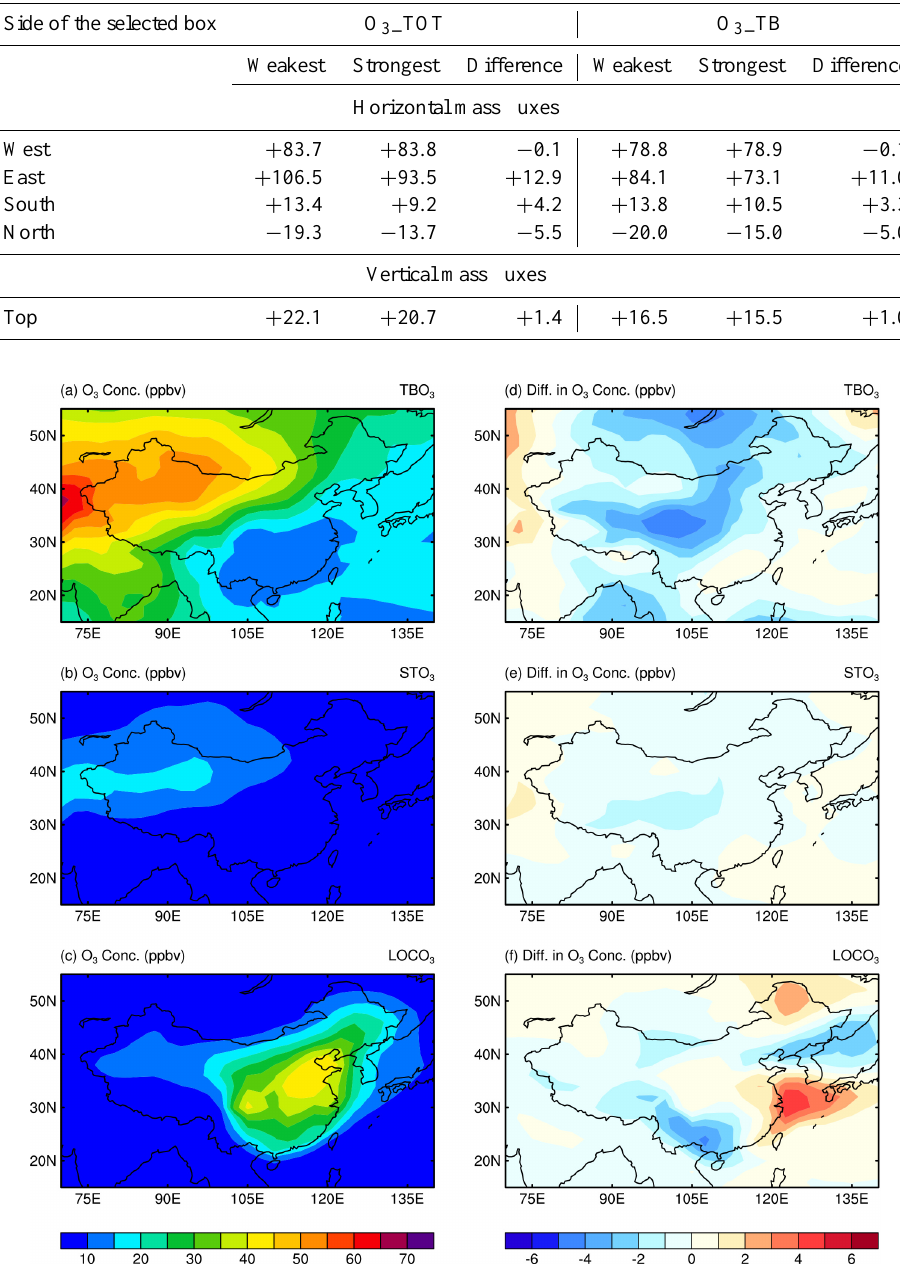
Figure 7. The JJA surface-layer O 3 concentrations (ppbv) from (a) simulation O 3 _TB (referred to as TBO 3 ) , (b) simulation O 3 _ST (referred to as STO 3 ) , and (c) simulation O 3 _TOT minus simulation O 3 _TB (referred to as LOCO 3 ) . (a) , (b) , and (c) are the averages over years 1986– 2006. (d) , (e) , and (f) are the composite differences (ppbv) in TBO 3 , STO 3 , and LOCO 3 , respectively, between the five weakest and strongest EASM years